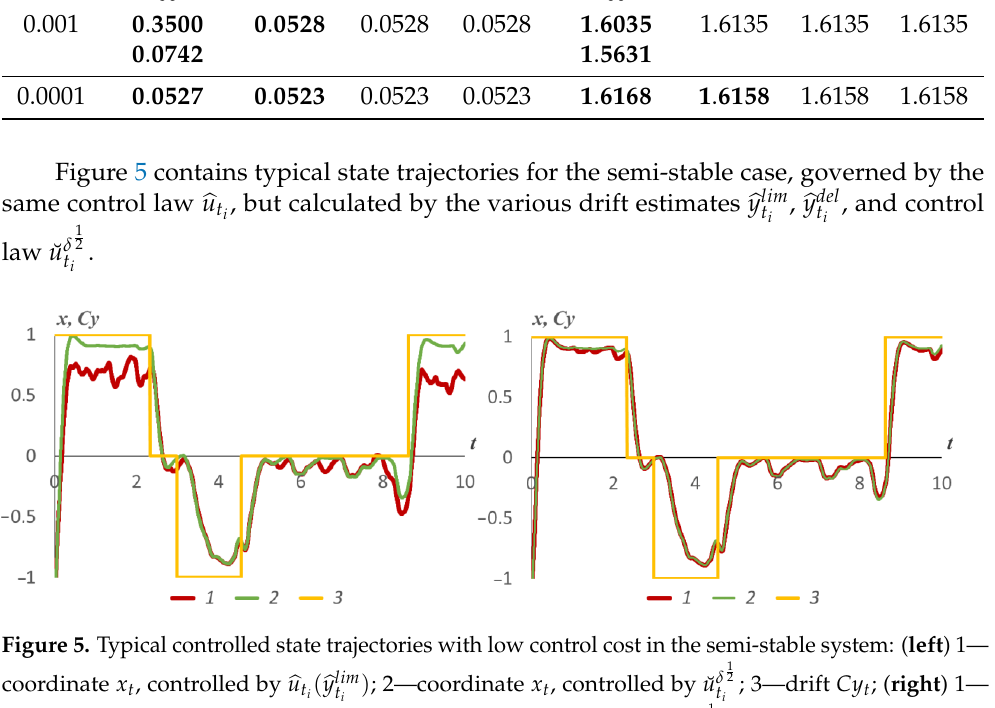
( (cid:98) y lim ) ; 2—coordinate x t , controlled by ˘ u δ t i i ( (cid:98) y del ) ; 2—coordinate x t , controlled by ˘ u δ t i i